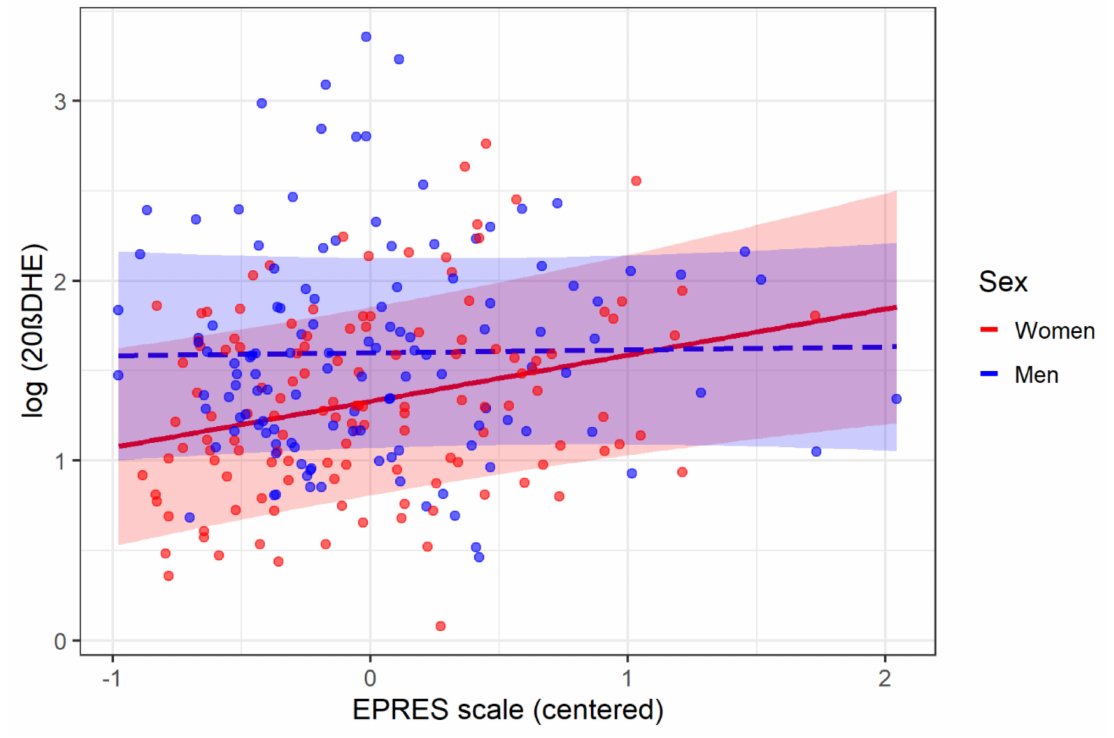
Figure 3. Plot of the interaction effect between sex and EPRES on 20 β DHE